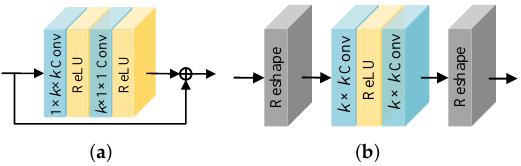
Figure 5. The detailed architecture of the 2D/3D unit. ( a ) 3D unit. ( b ) 2D